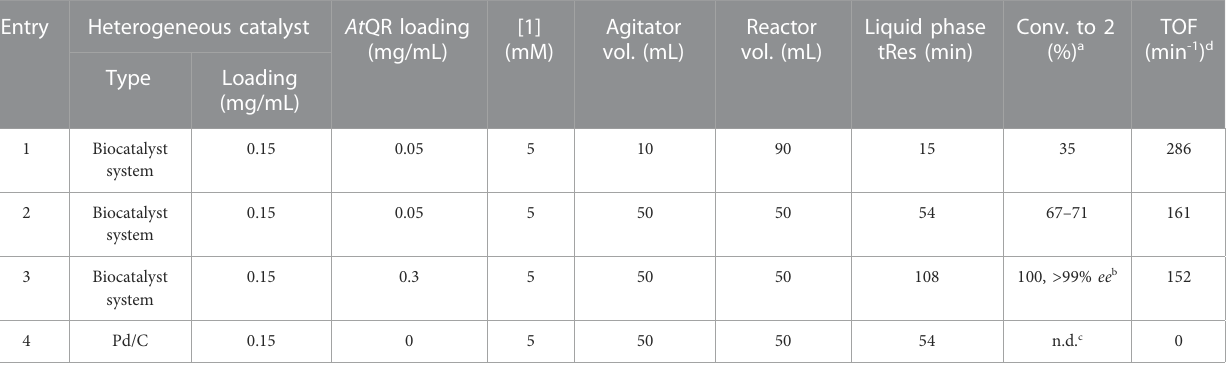
TABLE 3 Hydrogenation of 1 in continuous fl ow slurry